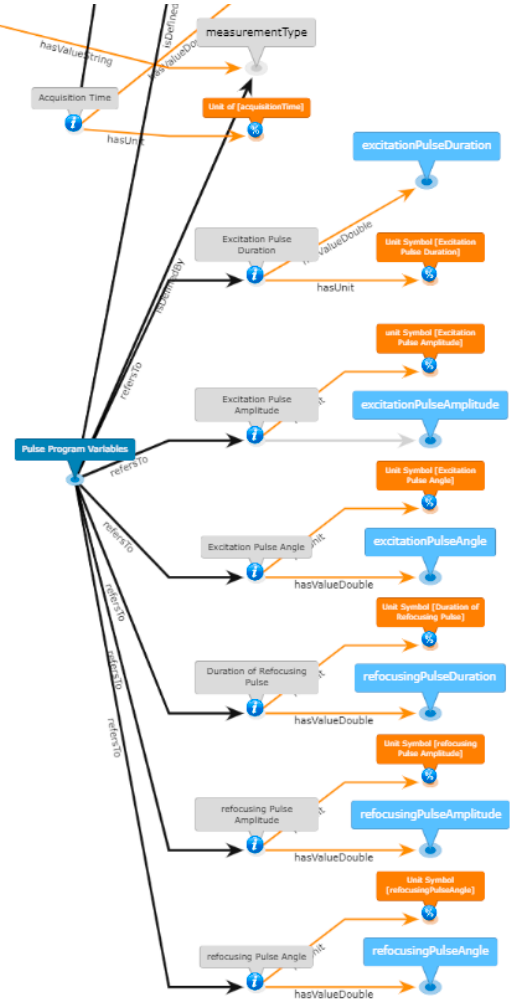
Figure A3. Zoom on Figure 9 Area 3. description of six variables of the NMR measurement used by the measurement machine software.